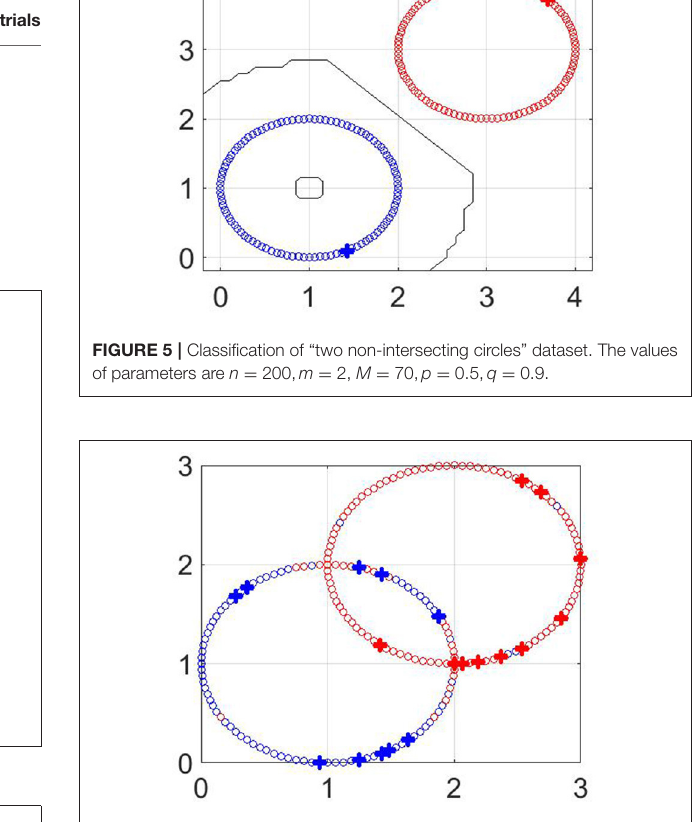
FIGURE 6 | Classification of “two intersecting circles” dataset. The values of parameters are n = 200, m = 20, M = 70, p = 0.5, q = 0.9.